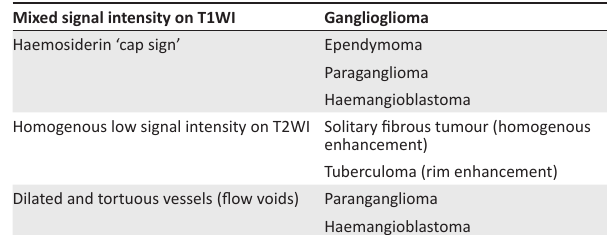
FIGURE 10: Intramedullary tuberculoma in an 18-year-old woman. Sagittal T2-weighted (a), sagittal T1-weighted (b) and sagittal contrast-enhanced T1-weighted (c) images demonstrate a T2 hypointense (white arrow) and T1 isointense (yellow arrow) intramedullary mass with rim enhancement post contrast administration (red arrow). There is extensive surrounding cord oedema on the T2-weighted image (blue arrows) (a). TABLE 3: Specific magnetic resonance imaging (MRI) characteristics of intramedullary